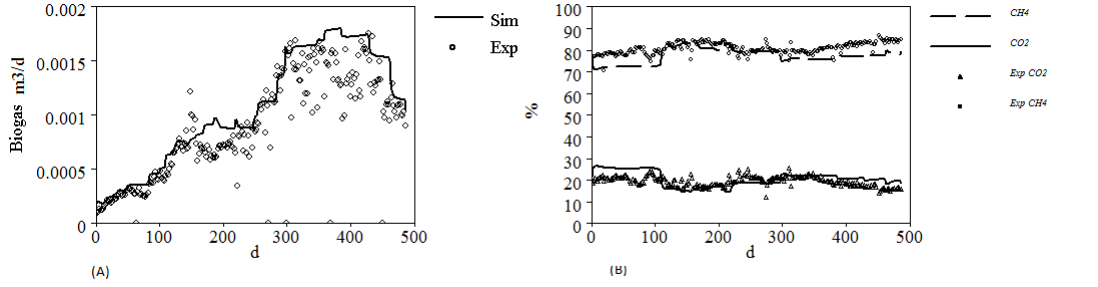
Figure 8: Simulated and experimental biogas generation (A) and CH 4 and CO 2 partial pressures (B)